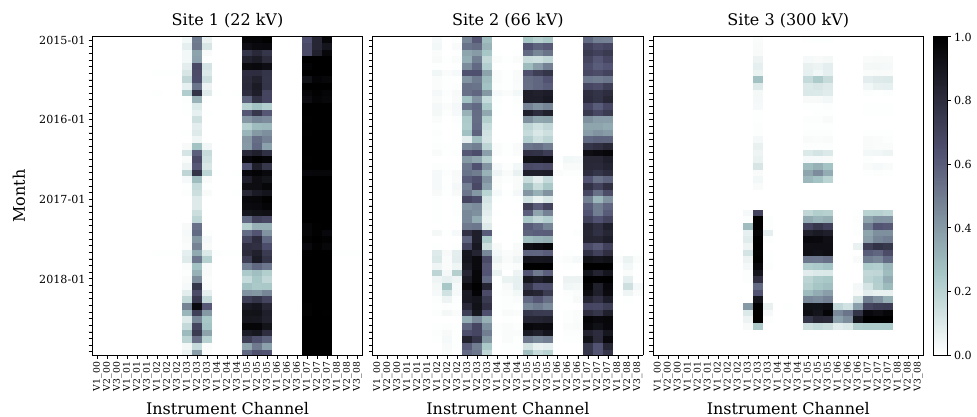
Figure 3. Fraction of non-zero observations for the first eight harmonics in each voltage channel (denoted as Instrument Channel ), grouped by harmonic. Data for all three sites are shown, see panel titles. A period of four years is covered for each site. The fraction (see colormap on the right) is calculated over ∼ 1.3 × 10 8 samples in each month. It is clear that there are some channels (harmonics for each phase) that are clearly more present than others, and that the pattern is to a large degree transferable from phase to phase and from site to site. It is also clear that there is considerably less harmonic content in the higher voltage levels. This is confirmed in Figures 5 and